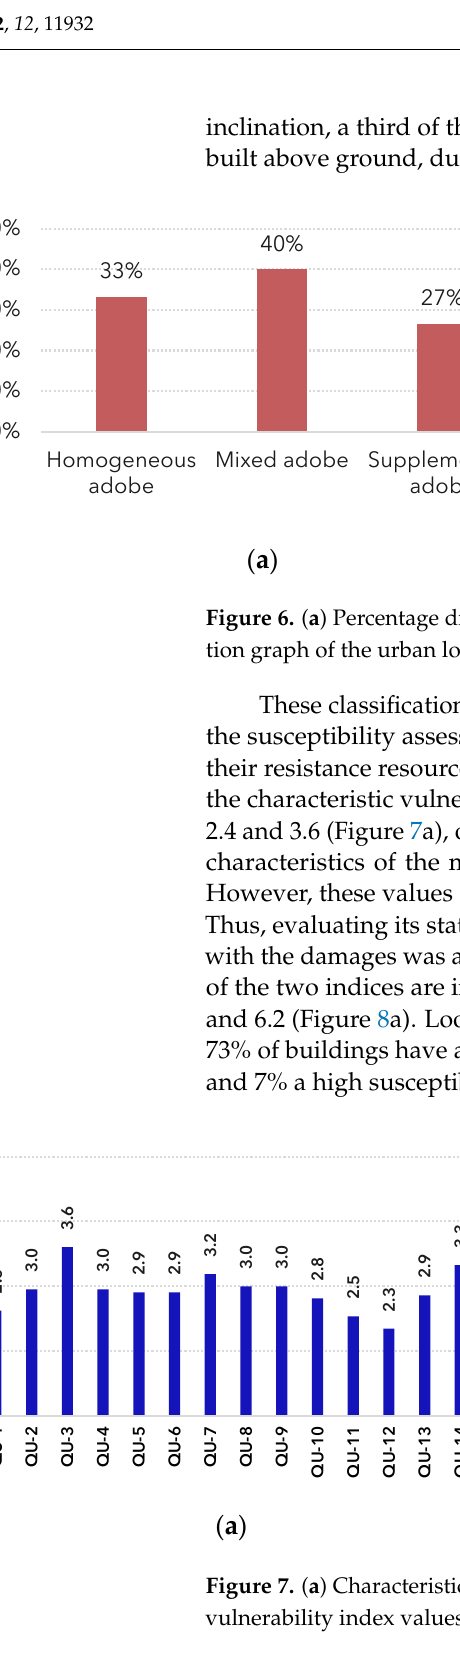
( b ) Figure 8. ( a ) Total vulnerability index graph; ( b ) Percentage distribution of the total vulnerability index values. Comparing the characteristic vulnerability and the total vulnerability, an increase in the value is observed. This increase is caused by the state of conservation of the asset, significantly changing the value of the index. For instance, if the QU-3 and QU-10 cases are analysed, QU-10 is noted to have increased its value, exceeding QU-3, and this is re- lated to the presence of forms of material weathering and damages affecting the walls. In fact, in almost all buildings, forms of deterioration were found, especially due to rising damp. This result is very striking because it is in direct correlation with the presence of the channelled and filled ravines, whose projected canalization works underestimating the flow they receive, causes problems of infiltrations in the soil. However, the analysis turns out that the wall supports on ashlar plinths are a construction feature, can be con- sidered a resource of resistance for the constructions, as they counteracts rising damp.